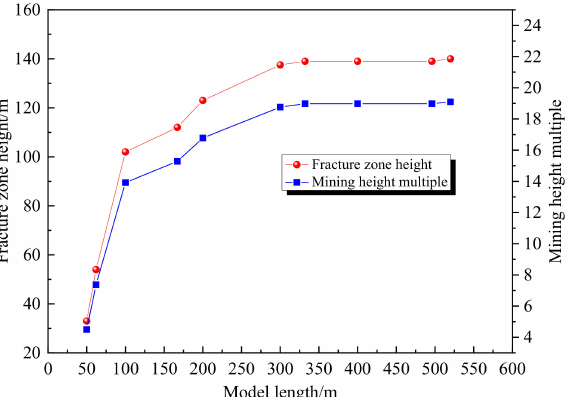
Figure 10. The development trends of the water-conducting fracture zone in the mining